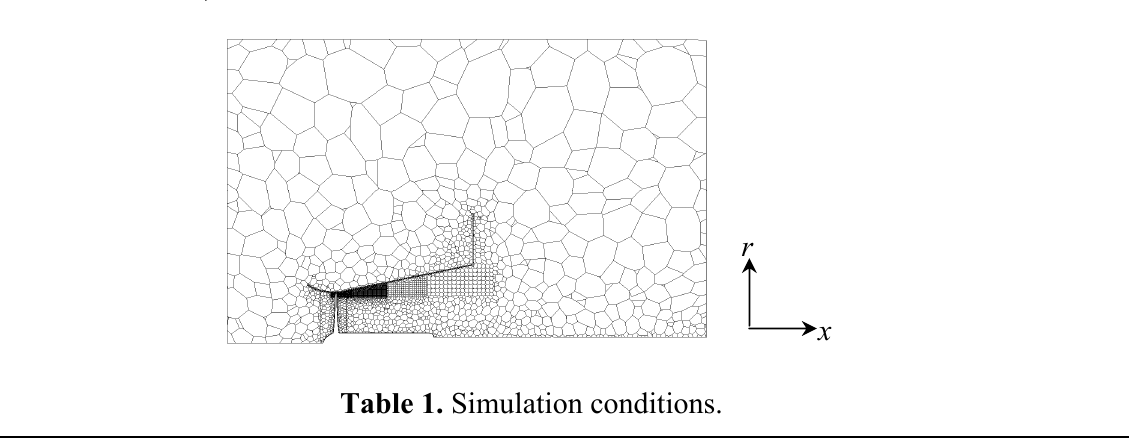
Figure 5. Calculation mesh for the long-type Wind-Lens turbine in an x - r cross-section. x : inflow direction; r : radial direction.